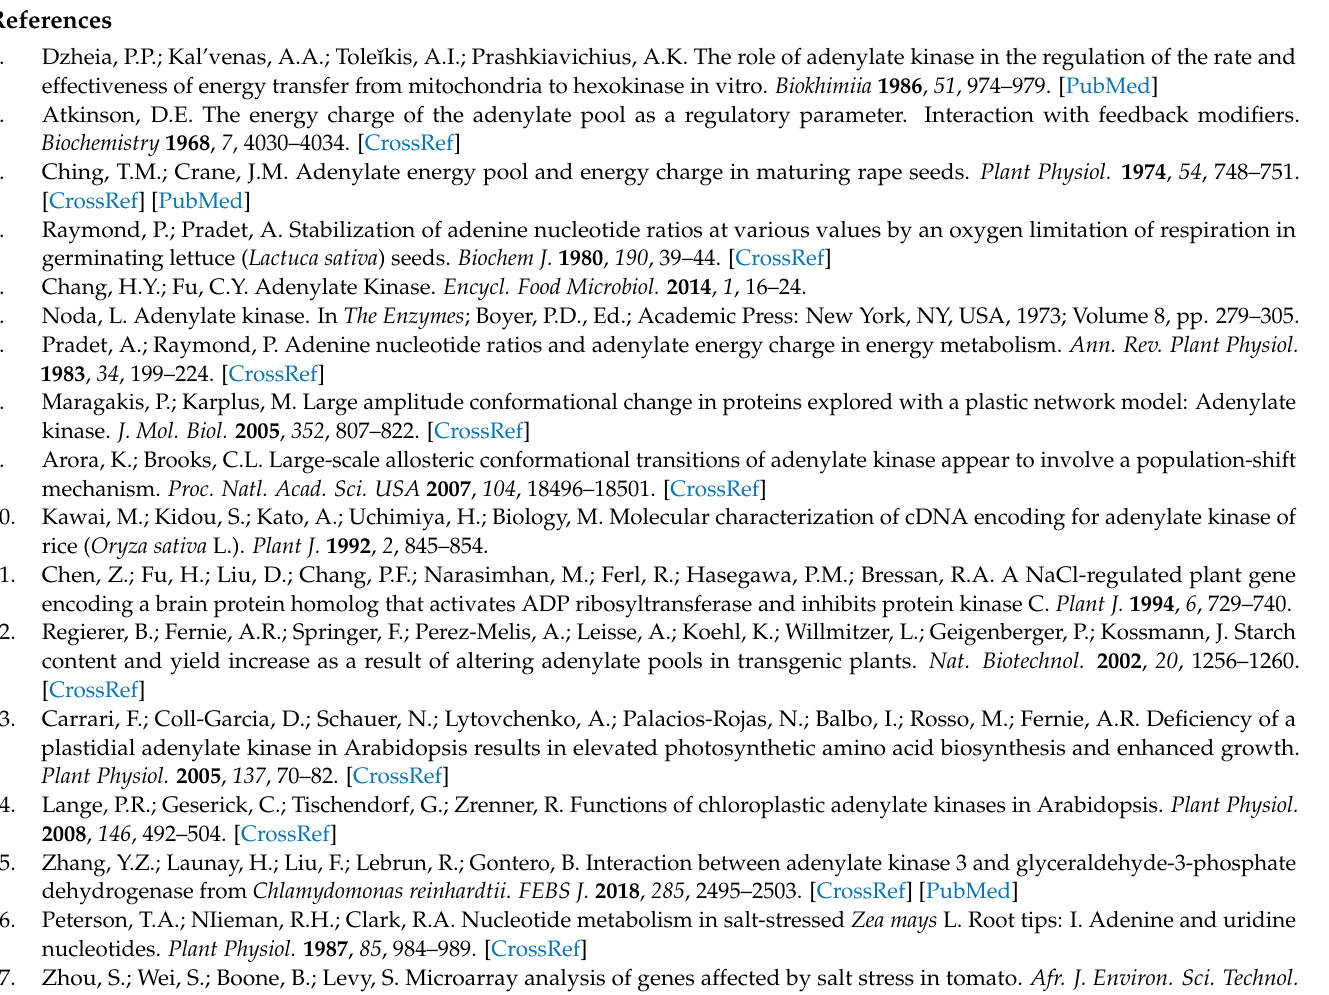
Coexpression and correlation network analysis. Figure S1. Expression level data sets of 11 SlADK genes in tomato different tissues and during fruit ripening. Figure S2. Expression level data sets of 11 SlADK genes in different tomato tissues under stress treatment. Figure S3. States of SlADK10